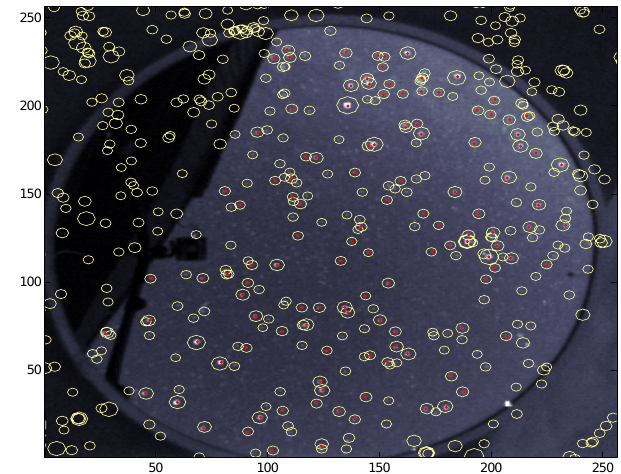
Fig. A4. Same as Fig. A2, but for the HAARPOON Apogee imager located at the HIPAS site, observation in 5577 ˚A.